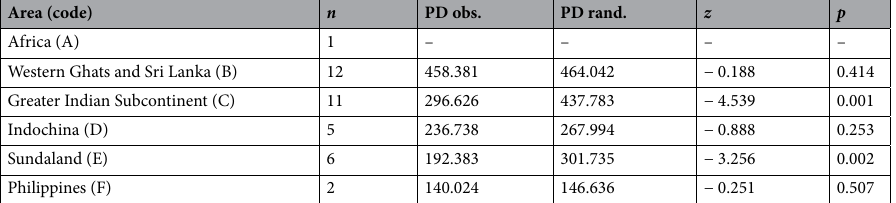
Table 4. Phylogenetic diversity (PD) of Asian forest scorpions (Scorpionidae: Heterometrinae) in six biogeographical regions (A–F): number of taxa per area ( n ); observed phylogenetic diversity (PD obs.); mean PD in null areas (PD rand.); standardized effect size of PD ( z ); probability ( p ).